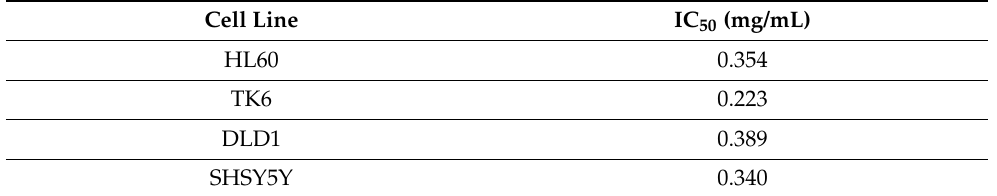
Table 1. IC 50 values calculated on different cell lines after one cell-cycle treatment with A. leucotrichus extract. Cell